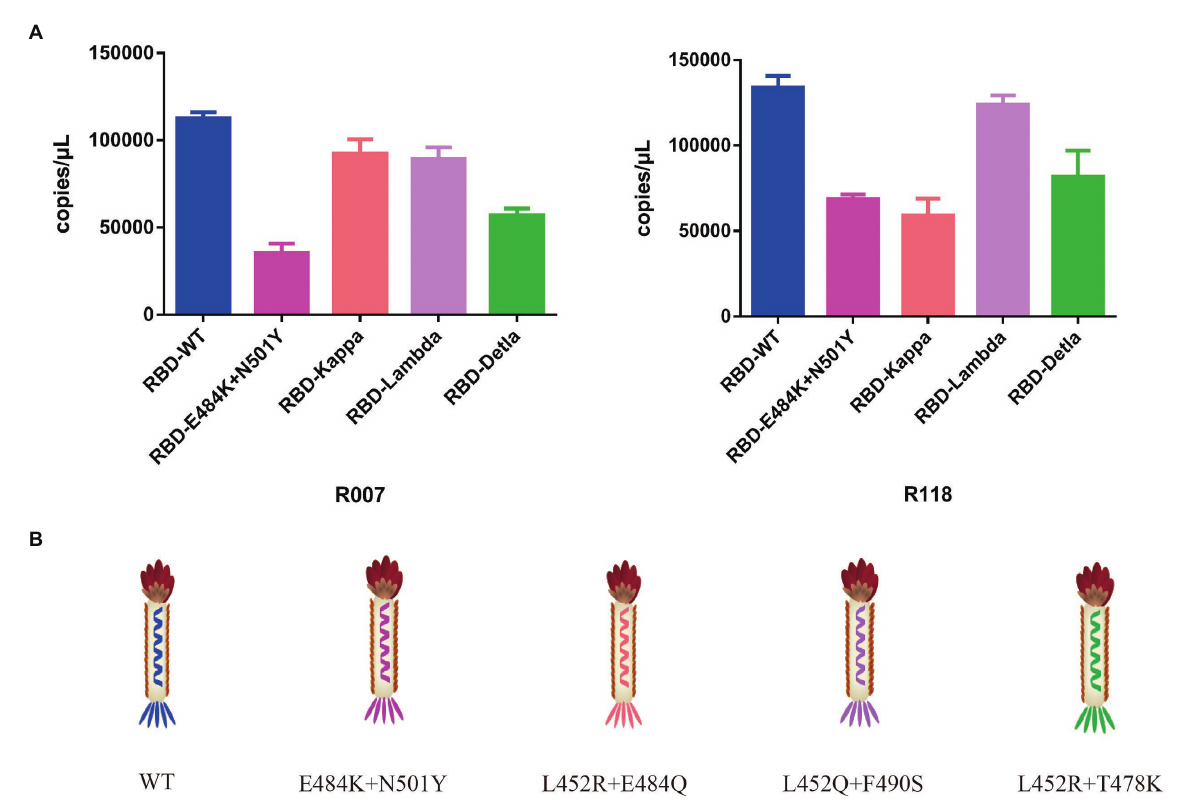
FIGURE 3 (A) The binding activity between the recombinant phage with different mutations in the RBD construct and two commercially available anti-RBD antibodies. (B) Schematic drawing of the phage of the phage-displayed RBD construct with different mutations. The values shown are the average of three independent experiments and their standard